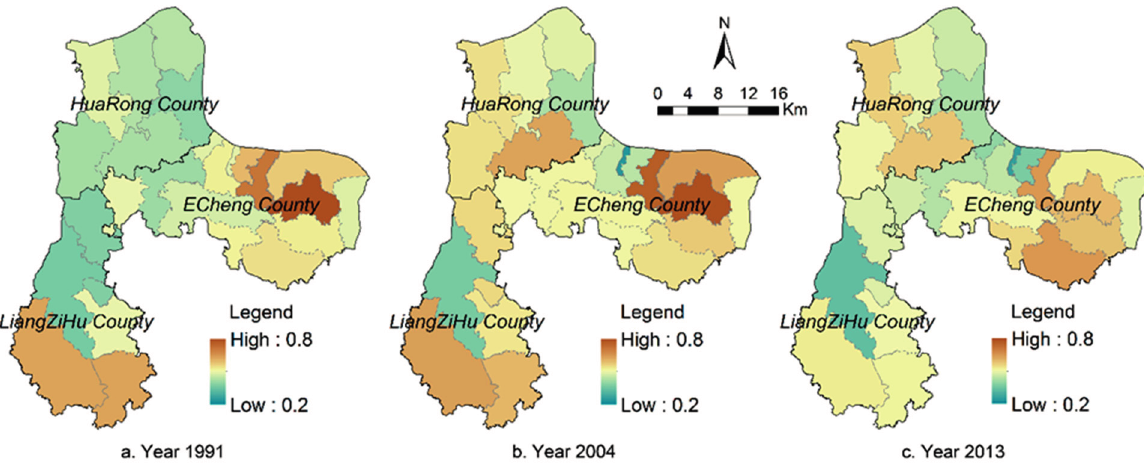
Figure 8. Maps of landscape ecological risk in the study region for year 1991, 2004, and 2013.